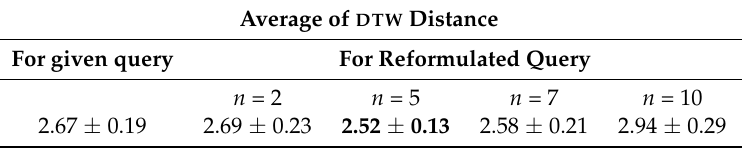
query with varying number of samples n from the query